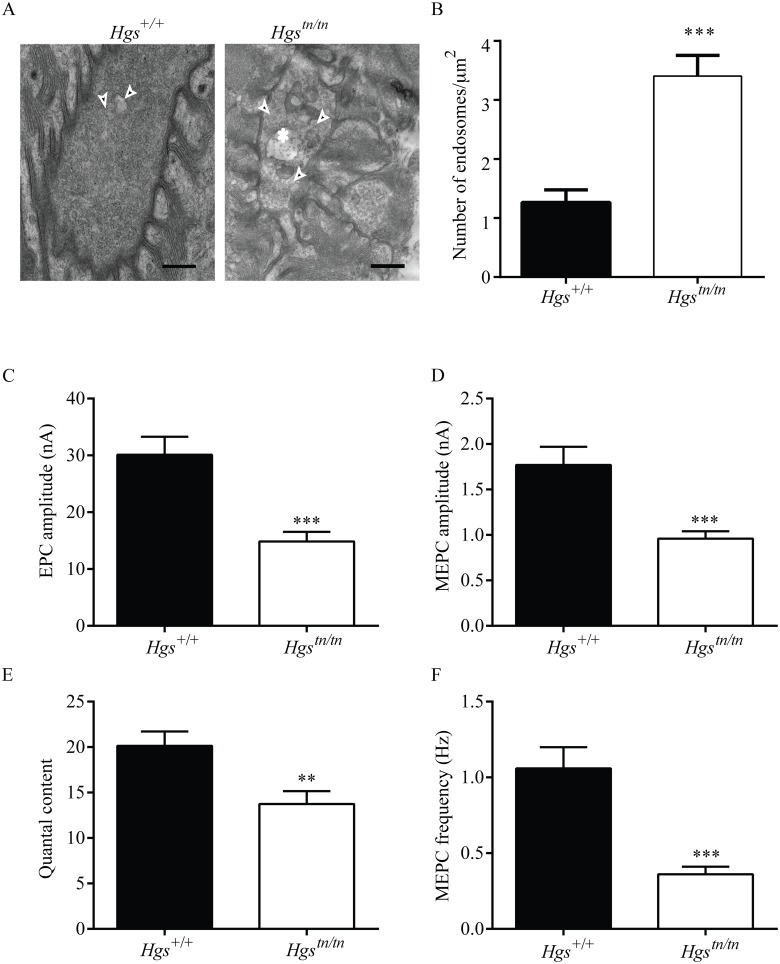
Loss of HGS increases the number of endosome-like structures and results in synaptic transmission deficits at the NMJ.(A) Representative electron micrographs of NMJs in the TA muscle from 4-week-old Hgs
+/+ and Hgs
tn/tn mice. Arrowheads point to endosomes-like structures. Asterisk marks an MVB in the Hgs
tn/tn presynaptic terminal. No MVBs were observed in Hgs
+/+ terminals. Scale bar, 500 μm. (B) Quantitation of endosome-like structures at the motor axon terminals. Symbol represents unpaired t-tests. (C) A 50% reduction in EPC amplitudes was observed in the endplates from 3-week-old Hgs
tn/tn mice (n = 12 endplates from 6 mice) as compared to controls (n = 12 endplates from 5 mice). (D) MEPC amplitudes were reduced in the Hgs
tn/tn mice (n = 19 endplates from 6 mice) to 46% of Hgs
+/+ controls (n = 15 endplates from 8 mice). (E) Quantal content was significantly lower in Hgs
tn/tn mice (n = 8 endplates from 6 mice) than in Hgs
+/+ controls (n = 12 endplates from 5 mice). (F) Reduced HGS expression results in a 65% reduction in MEPC frequency at the TA muscles of Hgs
tn/tn mice (n = 17 endplates from 6 mice) compared to Hgs
+/+controls (n = 14 endplates from 5 mice). Symbol represents unpaired t-tests **p<0.01 and ***p<0.001.